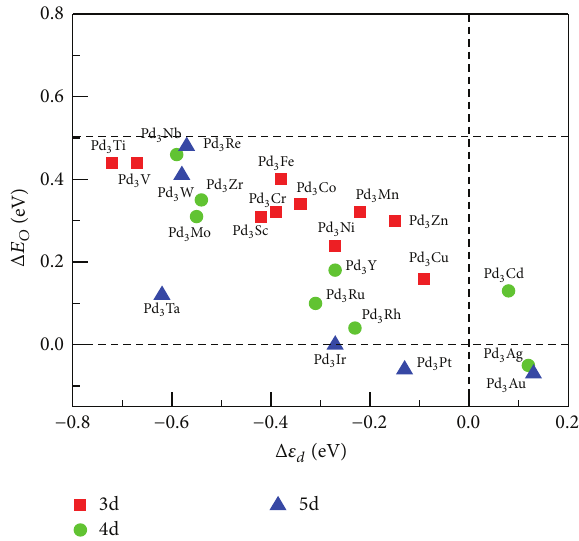
Figure 6: The relationship between the calculated adsorption , on Pd 3 M(111) surface and the calculated 𝑑 -band energies, Δ𝐸 O = 𝐸 O − 𝐸 O , Δ𝜀 𝑑 = 𝜀 𝑑 ( Pd M ) − 𝜀 𝑑 ( Pd ) . center, Δ𝜀 𝑑 , in which Δ𝐸 O 3 alloy Pt